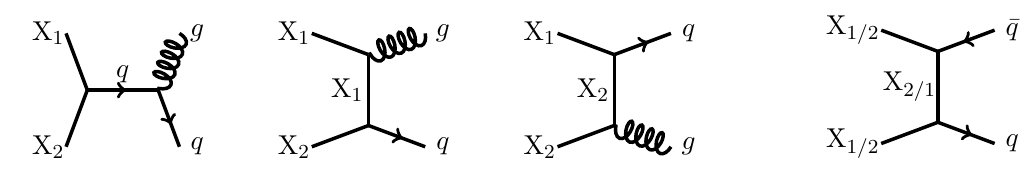
Figure 3 . The (cid:12)rst three diagrams show the mixed annihilation processes when a coupling between the two X’s and a SM quark is present. This coupling also introduces a new contribution to the self-annihilation rates of X 1 and X 2 as shown in the fourth